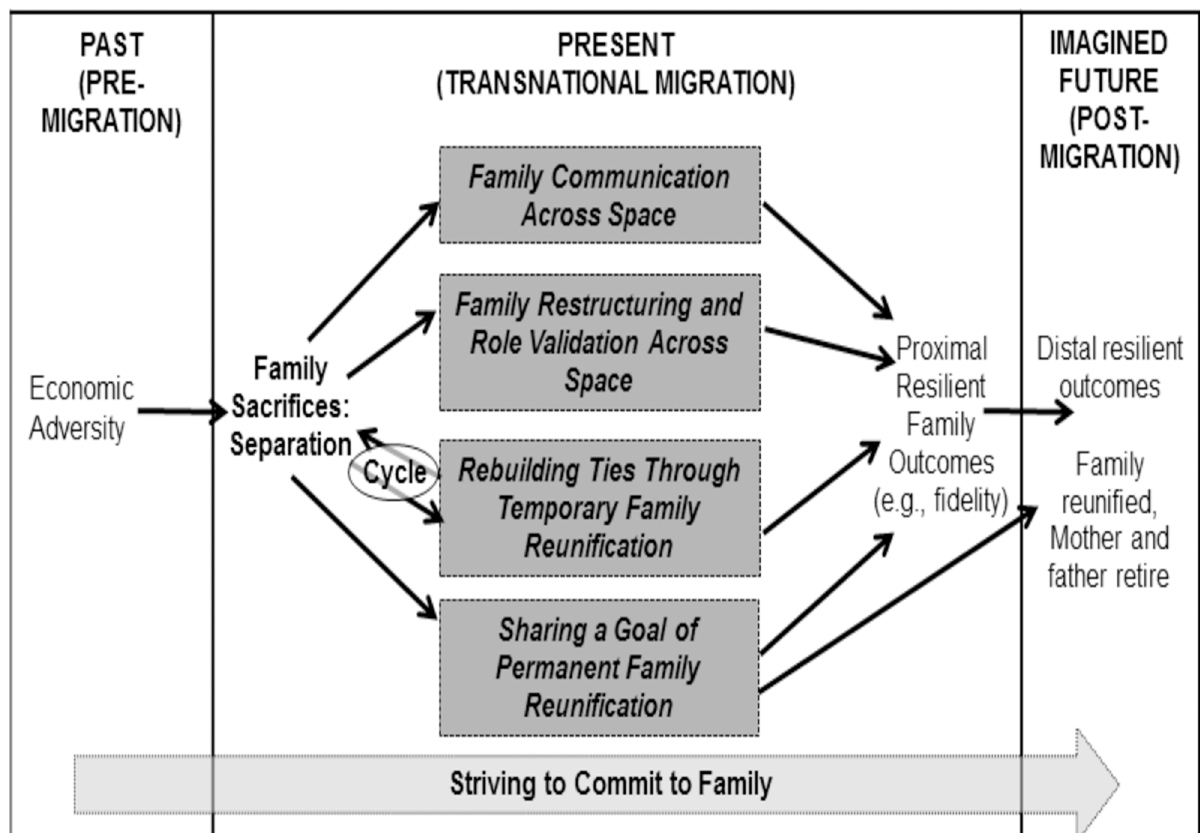
Fig 1. Model of resilience for transnational families of Filipina domestic